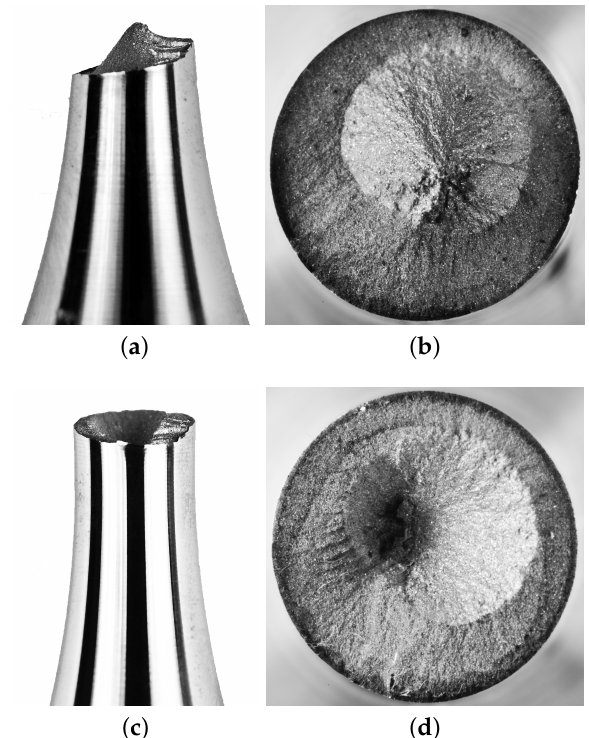
Figure 9. Final failure surface in case of specimens extracted from Bar A . ( a ) Cone, side view; ( b ) Cone, upper view; ( c ) Cup, side view; ( d ) Cup, upper view.